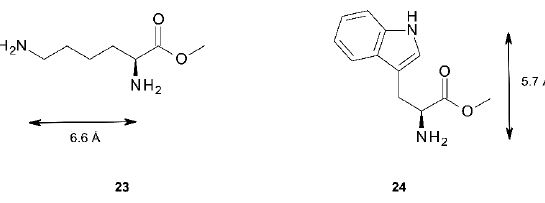
Figure 11. Chiral diamines 23 and 24 used in CD studies. The maximal N–N distances are indicated. Table 5. CD signal amplitudes (L × mol − 1 × cm − 1 ) for the complexes of tweezers Z- 1 and Z- 2 with chiral guests 23 and 24 at 20-fold excess. Measurements were performed at 25 °C for CH 2 Cl 2 solutions at tweezer concentration of 33 µM.